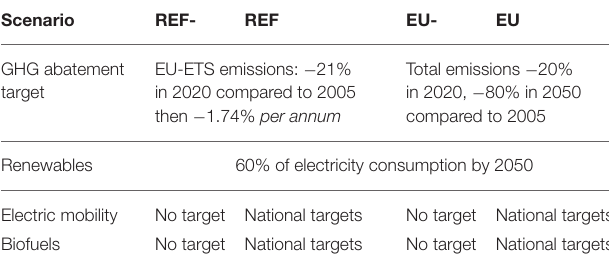
TABLE 3 | Overview of 4 scenarios explored by TIMES